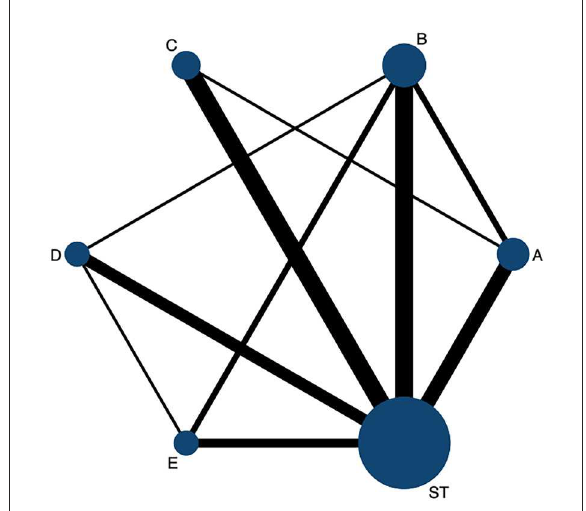
acupuncture; SBA, scalp-body acupuncture; STA, scalp-tongue